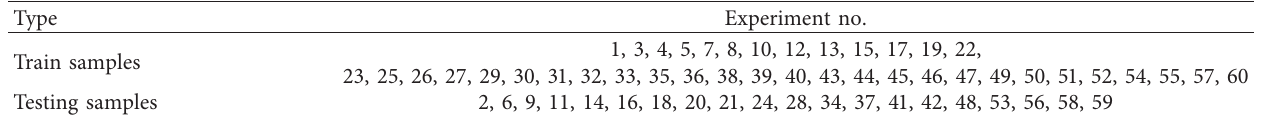
Table 5: Train and testing samples.